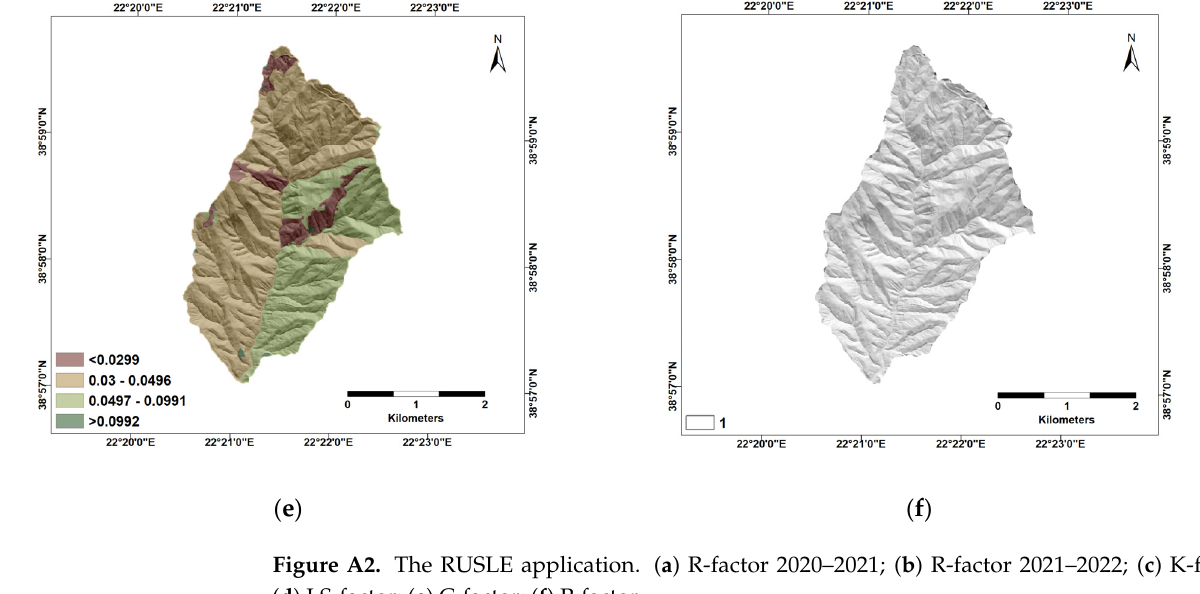
Figure A2. The RUSLE application. ( a ) R-factor 2020–2021; ( b ) R-factor 2021–2022; ( c ) K-factor; ( d ) LS-factor; ( e ) C-factor; ( f ) P-factor. Table A8. R-factor values, analytical estimation, Makrakomi station, September 2020–August